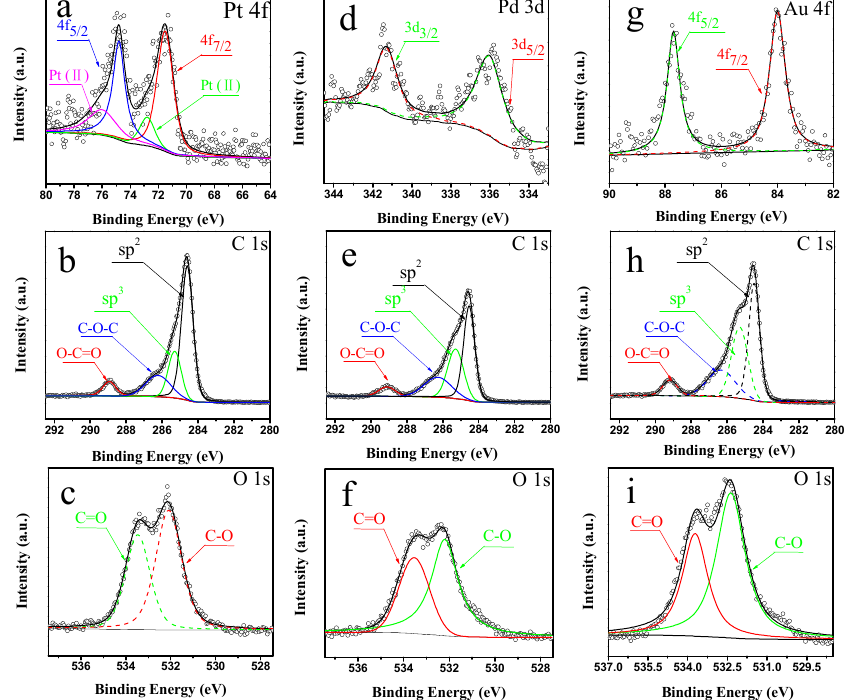
Figure 2. XPS spectra of Pt/CNTs ( a – c ), Pd/CNTs ( d – f ), and Au/CNTs ( g – i ) catalysts. 2.2. Electrochemical Characterization of Pt, Pd, and Au Disk Electrodes Cyclic voltammograms of commercial Pt, Pd, and Au disk electrodes in alkaline, acid, and neutral supporting electrolyte were conducted and are shown in Figure 3. The voltammogram of a Pt disk electrode recorded in 0.1 M KOH under N 2 saturation displays three regions according to the applied potential (Figure 3a). Region I at lower potentials is associated with the adsorption (reduction peaks)-desorption (oxidation peaks) of hydrogen, whereas region III at higher potentials reveals the adsorption (oxidation peaks)-desorption (reduction peak) of oxygenated species at the electrode surface. Between them is the double-layer region II, where no net electrochemical reaction occurs, and which is characterized by small currents associated with the charge and discharge of the double- layer capacity [26]. The pattern of a Pd electrode is similar to that of a platinum electrode. However, the onset potential of region III is much more positive than that of a platinum electrode. In the case of the Au electrode, the hydrogen region disappeared. When the same experiments were performed in acid medium, 0.1 M HClO 4 , and neutral medium, 0.05 M K 2 SO 4 , instead of alkaline electrolyte, the main features of both voltammograms remain unchanged (Figure 3b for acid and Figure 3c for neutral supporting electrolyte). For a Pt disk electrode, the onset potential of the oxygen region, which is related to earlier OH adsorption, gradually becomes positive as the electrolyte’s pH decreases. When the pH varies from 1 to 13, the range of the onset potential is about − 0.2 to 0.4 V/vs. RHE. However, when it comes to Pd electrodes, except that the onset potential of the oxygen region is 0.1 V when the pH is 13, the onset potential in neutral medium is 0.6 V. When the pH is 1, the potential is as high as 0.75 V. The onset potential for an Au electrode in acidic and neutral media is more positive than Pd. When the pH is 13, the onset potential for Pd is 0.15 V and for Au it is about 0.35 V. Although the onset potential changes when other solutes are present in the solution, these phenomena may explain part of the results, which will be given below.